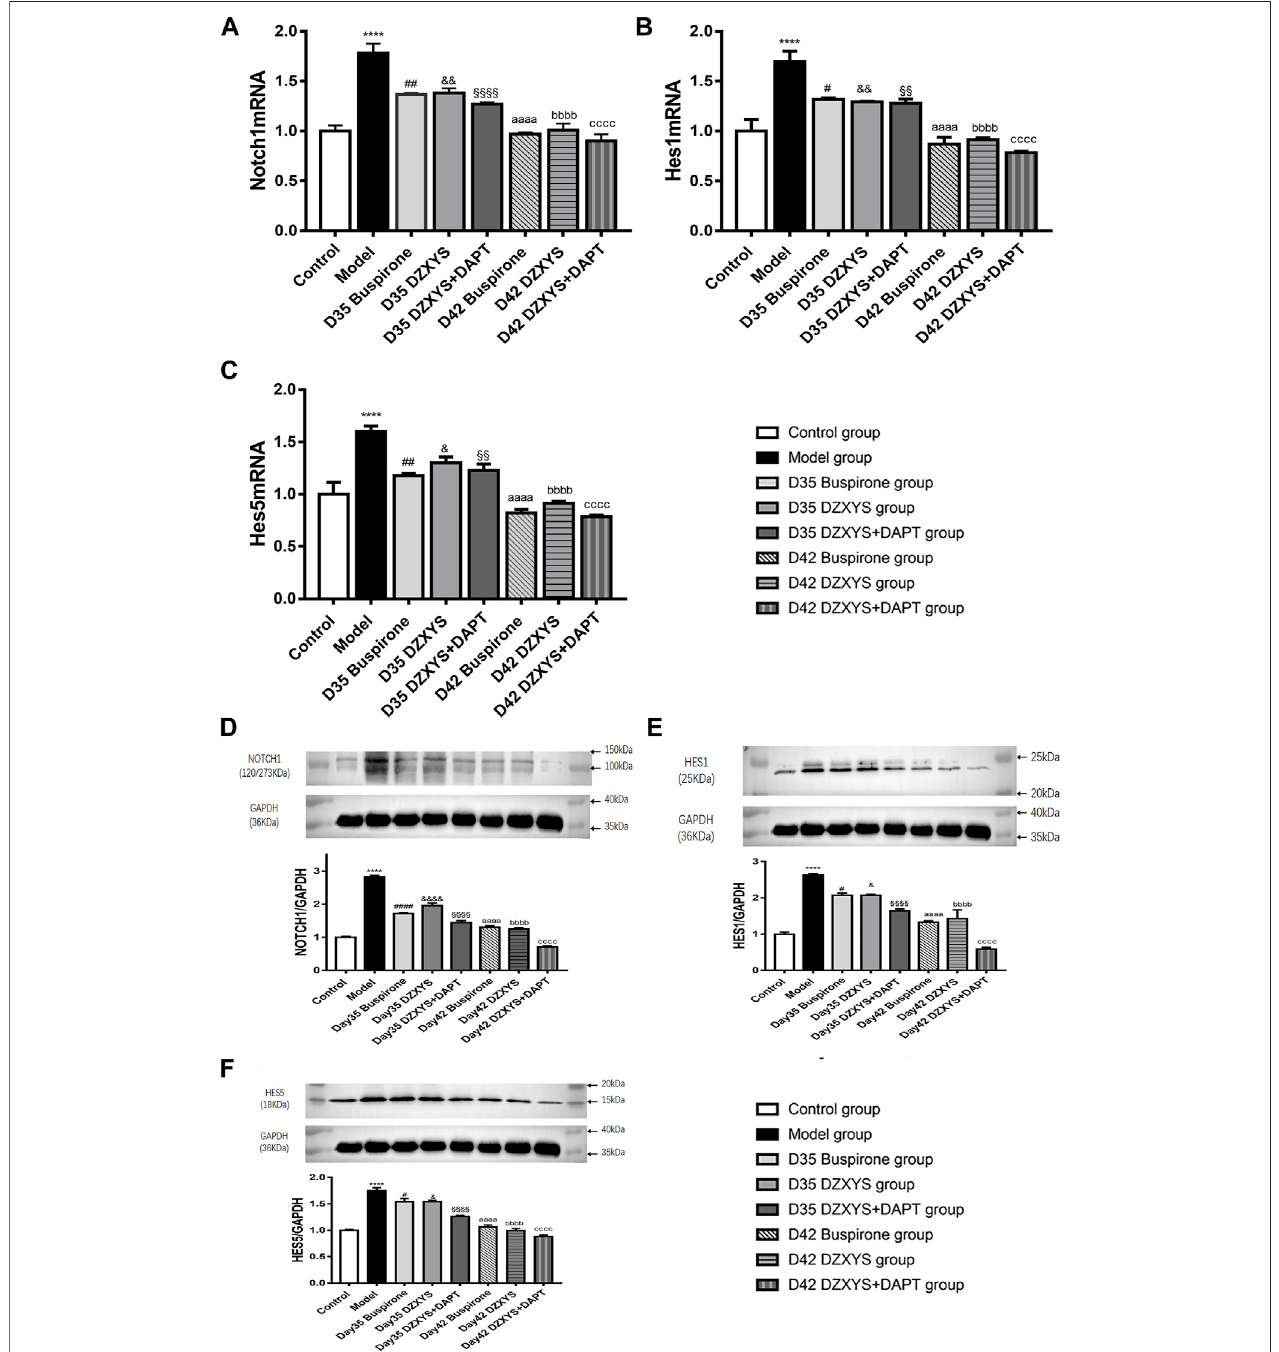
FIGURE 10 | The expression levels of Notch1, Hes1 and Hes5 mRNA transcripts in the hippocampus of rats in each group on the 35th and 42nd days after modelingweremeasured (A) Notch1mRNAexpression (B) Hes1mRNAexpression (C) Hes5mRNAexpression. FiguresD – F showtheelectrophoreticbandsoftarget protein and GAPDH in hippocampus of rats in different treatment groups, and the relative optical density of target protein in hippocampus of rats in different treatment groups were compared. The results were expressed as the percentage of the optical density of the target protein in the hippocampus of rats, including Notch1 (FigureD) 、 Hes1 (FigureE) 、 Hes5 (FigureF) .Alldataareexpressedasthemean ± SEMfromindependentexperimentsperformedintriplicate.**** p < 0.0001,model group vs. controlgroup; # p < 0.05, ## p < 0.01, #### p < 0.0001, Day 35Buspironegroup vs Modelgroup; and p < 0.05, && p < 0.01, &&&& p < 0.0001, Day 35DZXYS groupvs.modelgroup;§§ p < 0.01,§§§§ p < 0.0001,Day35DZXYS+DAPTgroupvsmodelgroup;aaaa p < 0.0001,Day42BuspironegroupvsModelgroup;bbbb p < 0.0001, Day 42 DZXYS group vs. model group; cccc p < 0.0001, Day 42 DZXYS + DAPT group vs model group.